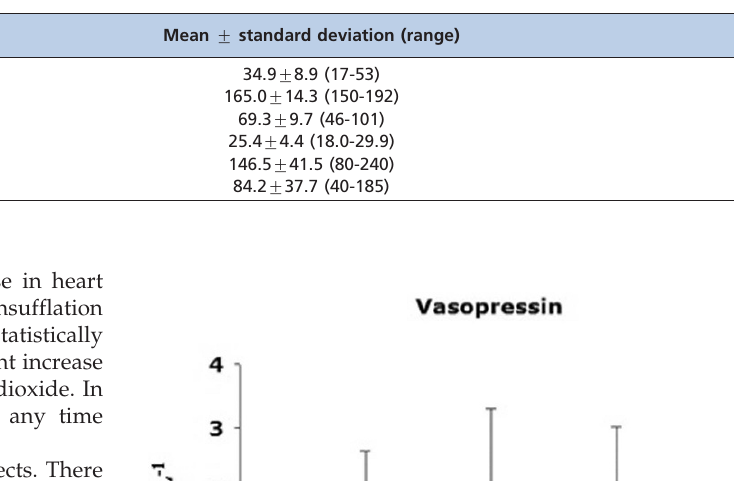
Table 1 - Biometric data and the duration of anesthesia and pneumoperitoneum. The data are presented as the mean ¡ standard deviation. The range of the variables is also included in the table.